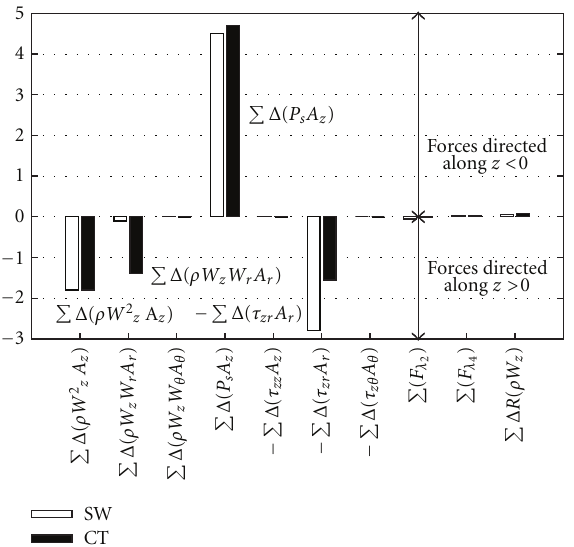
Figure 12: CREATE-R2 with and without CT: balance of the axial momentum equation.